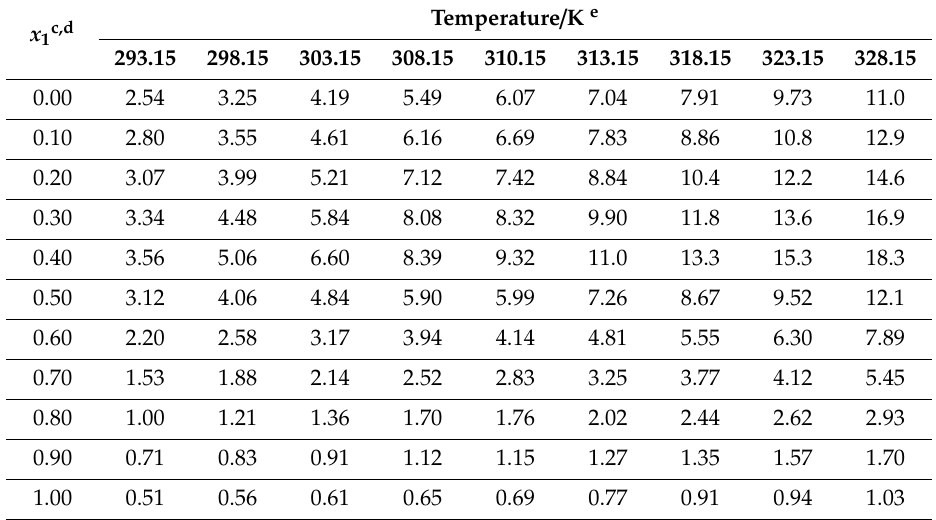
Table 1. Experimental solubility of amygdalin (3) expressed in molar fraction (10 3 x 3 a ) in [ethanol (1)